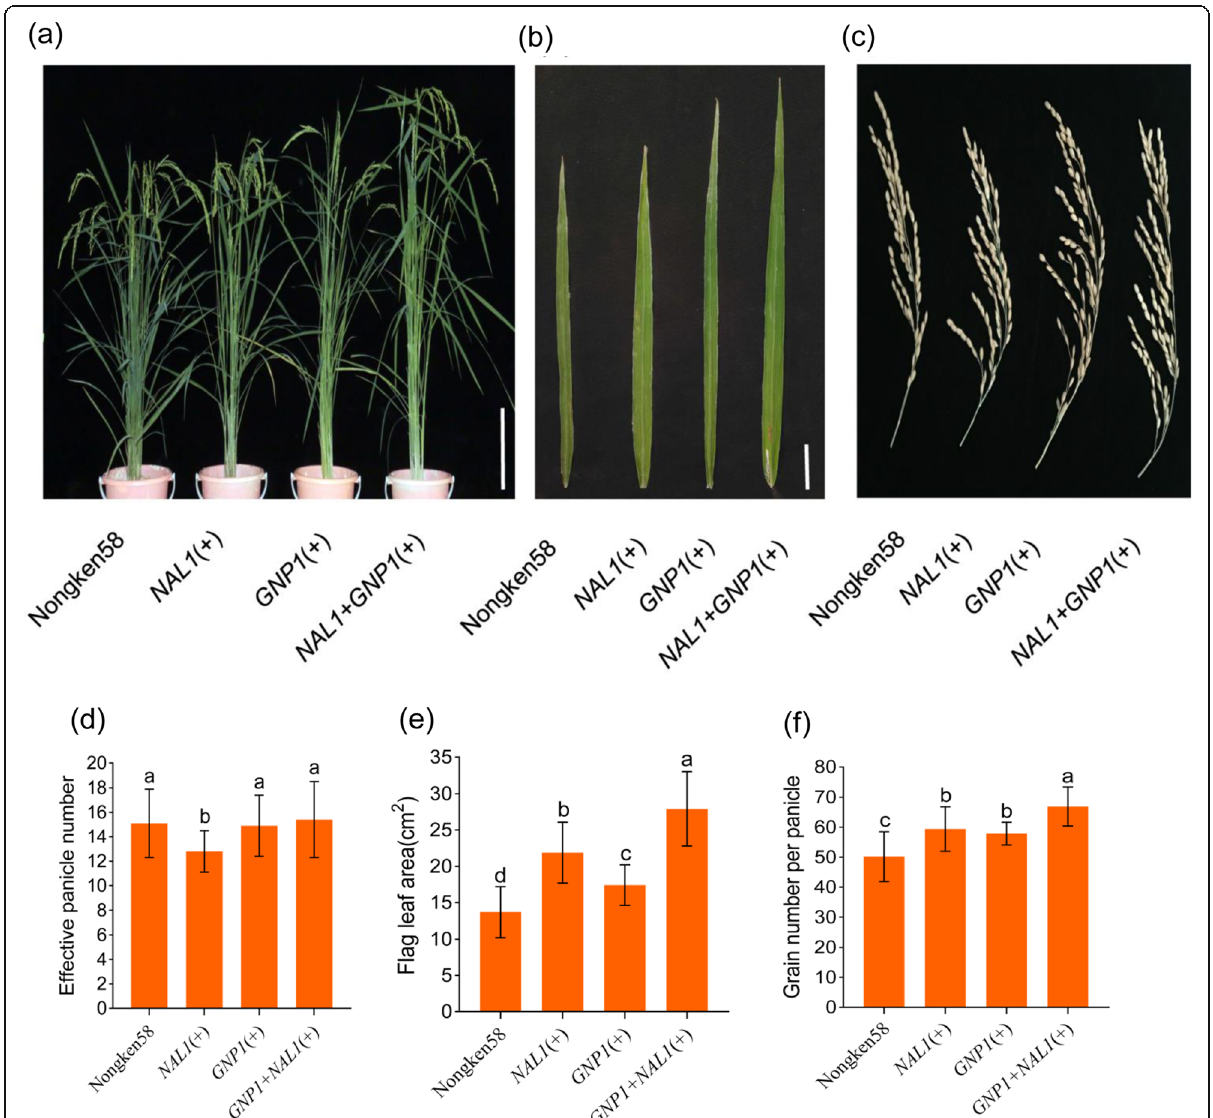
Fig. 3 Performance of three homozygous transgenic lines in the T 3 generation under nature conditions. a – c Cross morphologies ( a ) flag leaf morphologies ( b ) panicle morphologies ( c ) of the lines with NAL1 or GNP1 , the lines carrying both NAL1 and GNP1 , and Nongken58 (transgenic control). (+) indicate transgene-positive. d – f Effective panicle number ( d ) flag leaf area ( e ) grain number per panicle ( f ) are compared the lines with either NAL1 or GNP1 with the lines carrying both NAL1 . Error bars indicate SD. Letters on histograms (a, b, and c) are ranked by Duncan ’ s test at P < 0.05. Scale bars represent 10 cm (a) or 2 cm